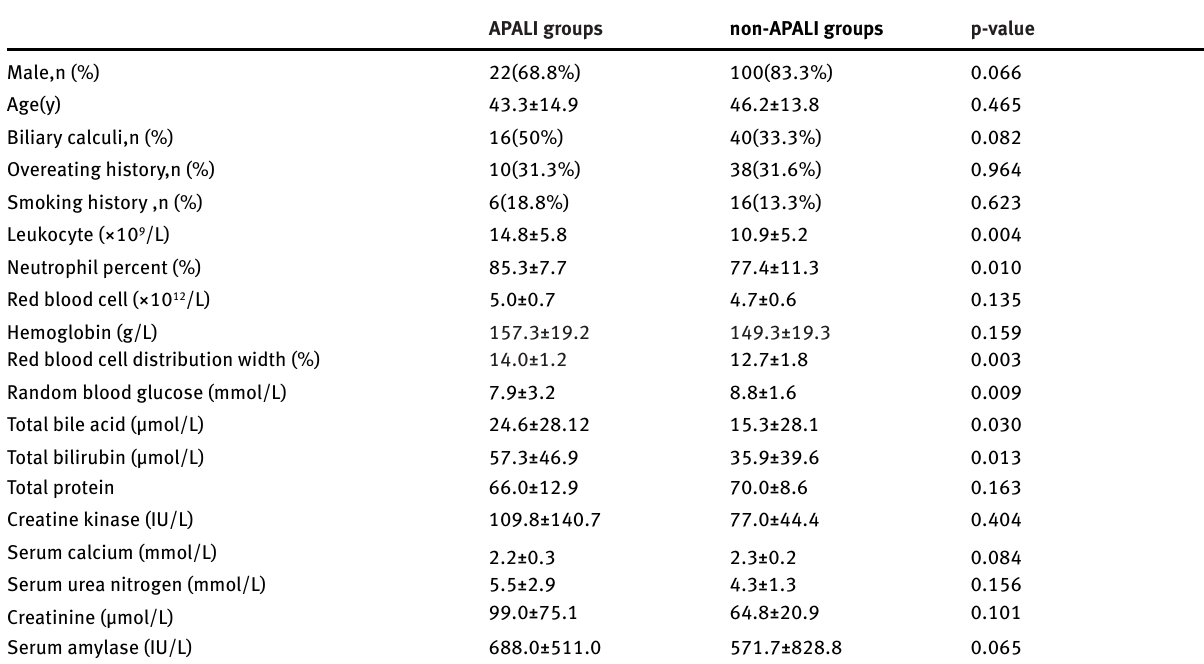
Table 1: Demographical and Laboratory Data for Participants